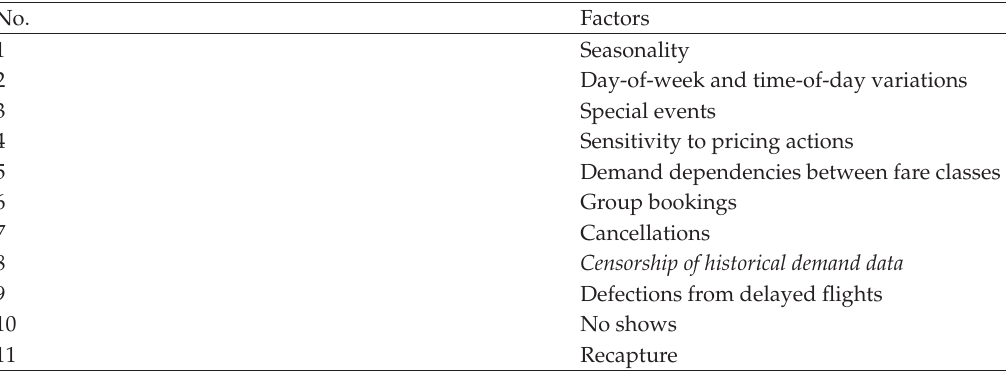
Figure 1: Booking pace curve of a fare class. Table 3: Factors impacting on forecasting of